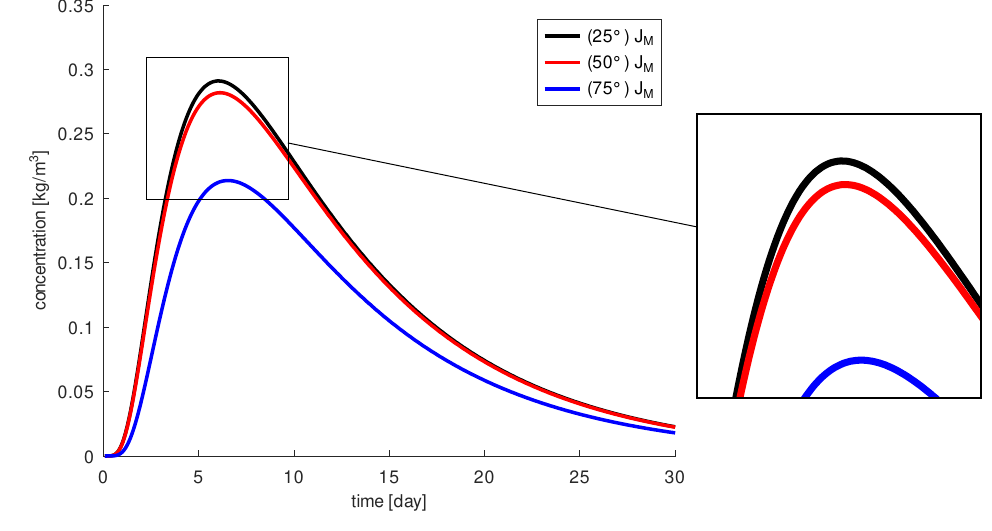
Figure 7. The amount of drug concentration at the macula, J M , depending on the penetration angle ψ xy : 25 ◦ (black), 50 ◦ (red) and 75 ◦